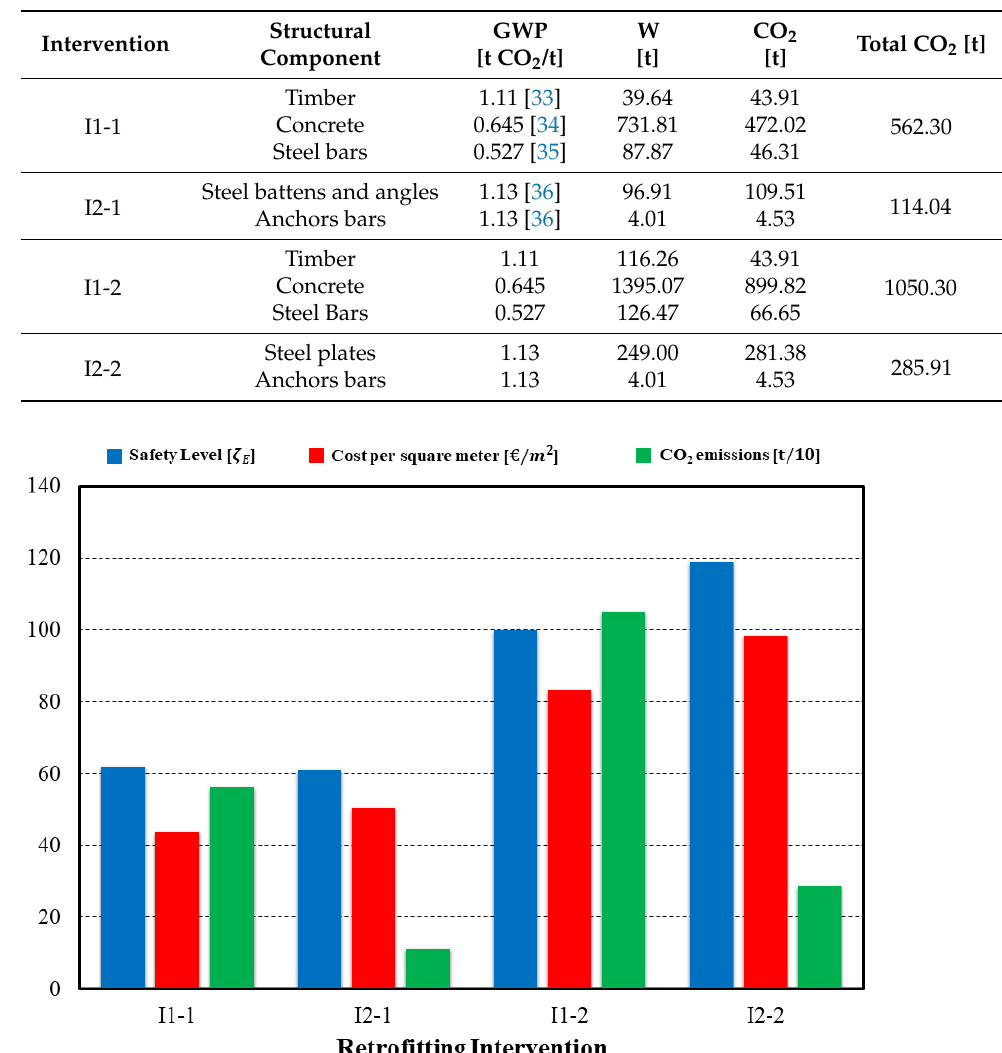
Table 18. Values of GWP parameter for the product stages.